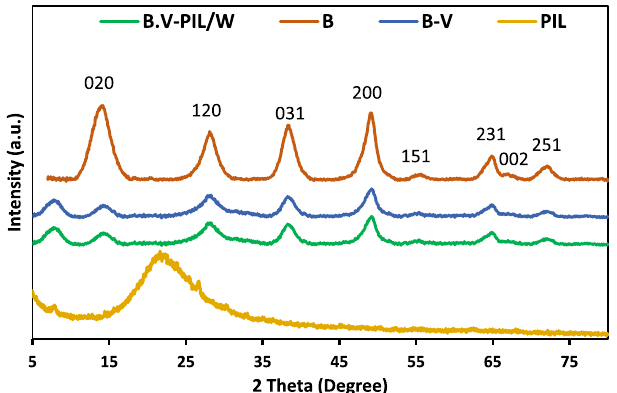
Figure 7. XRD patterns of boehmite (B), B-V, PIL, and B-V-PIL/W.